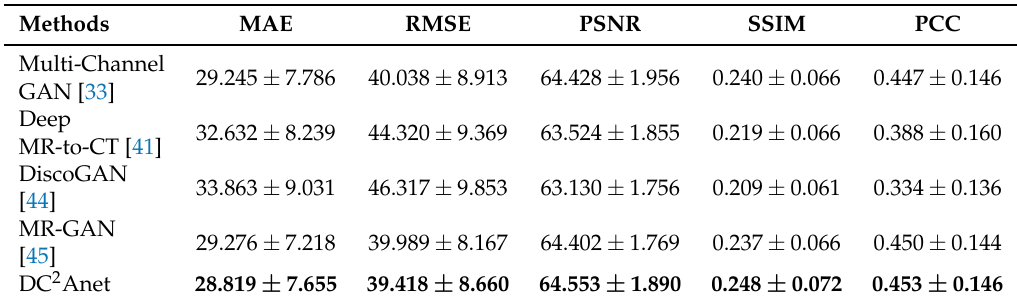
Table 10. Overall statistics for five measures of model quality: MAE, RMSE, PSNR, SSIM, and PCC. The average and standard deviation for each measure from 92 subjects in a lumbar vertebra dataset are presented for five methods. The best scores are displayed in bold.